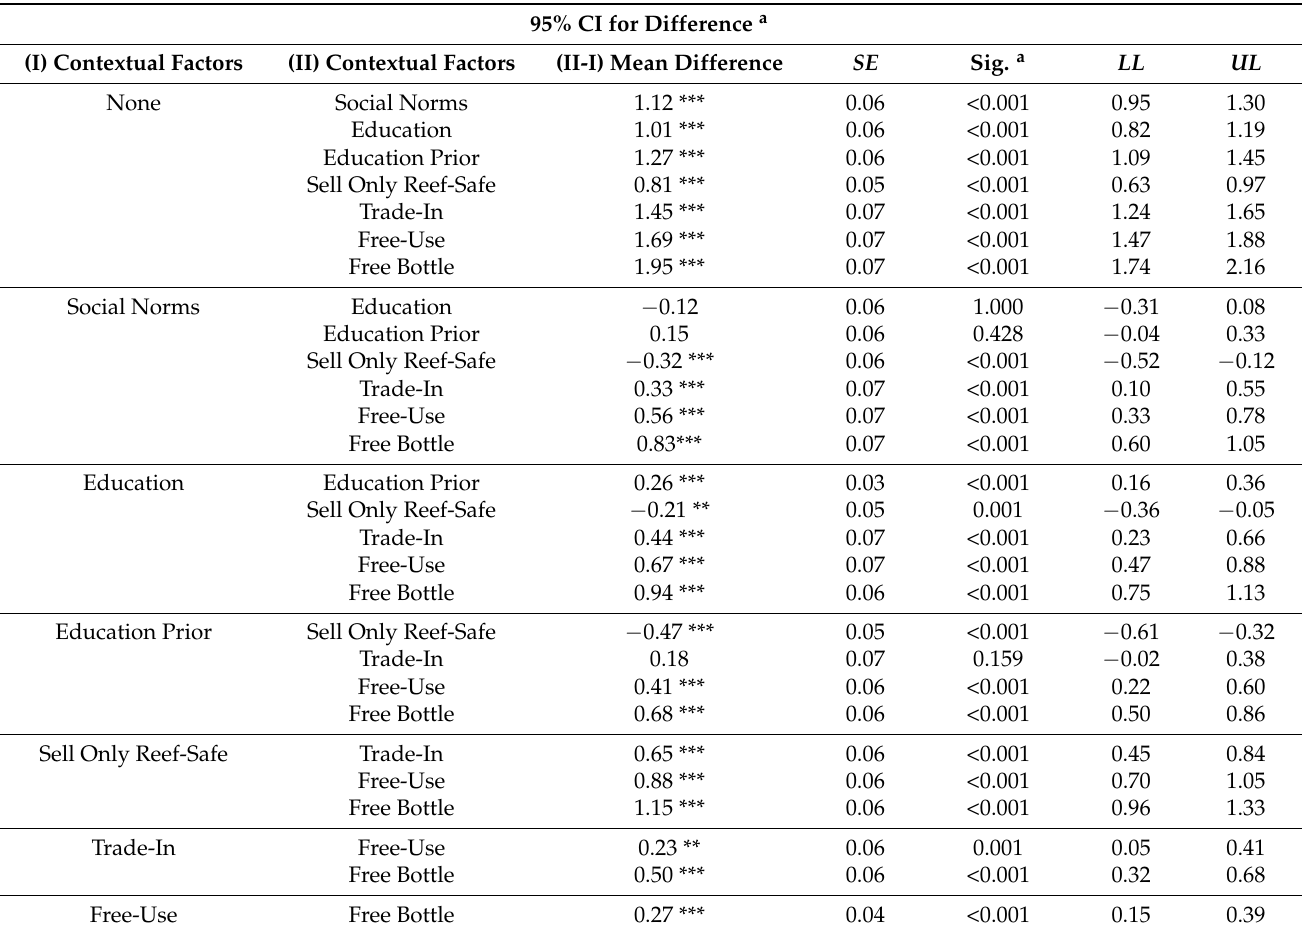
Table 8. Proposed hotel practices: pairwise comparisons of mean differences in Intention. 95% CI for Difference